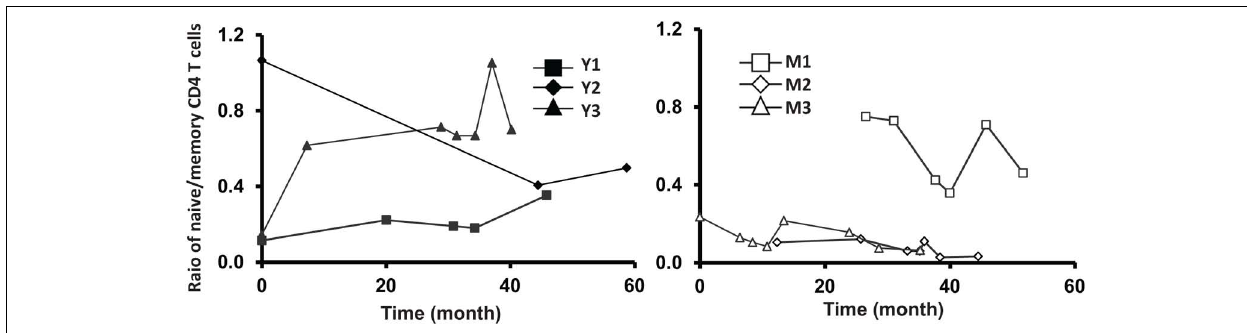
FIGUREA2 | Relative stable ratio of naïve/memory CD4T cells of six frequent leukapheresis donors throughout 3–5 years. PBMC were isolated and stained with CD4, CD45RA, and CCR7. Naïve CD4T cells were defined by CD4 + CD45RA + CCR7 + and memory cells were defined by CD4 + CD45RA − CCR7 + / − .